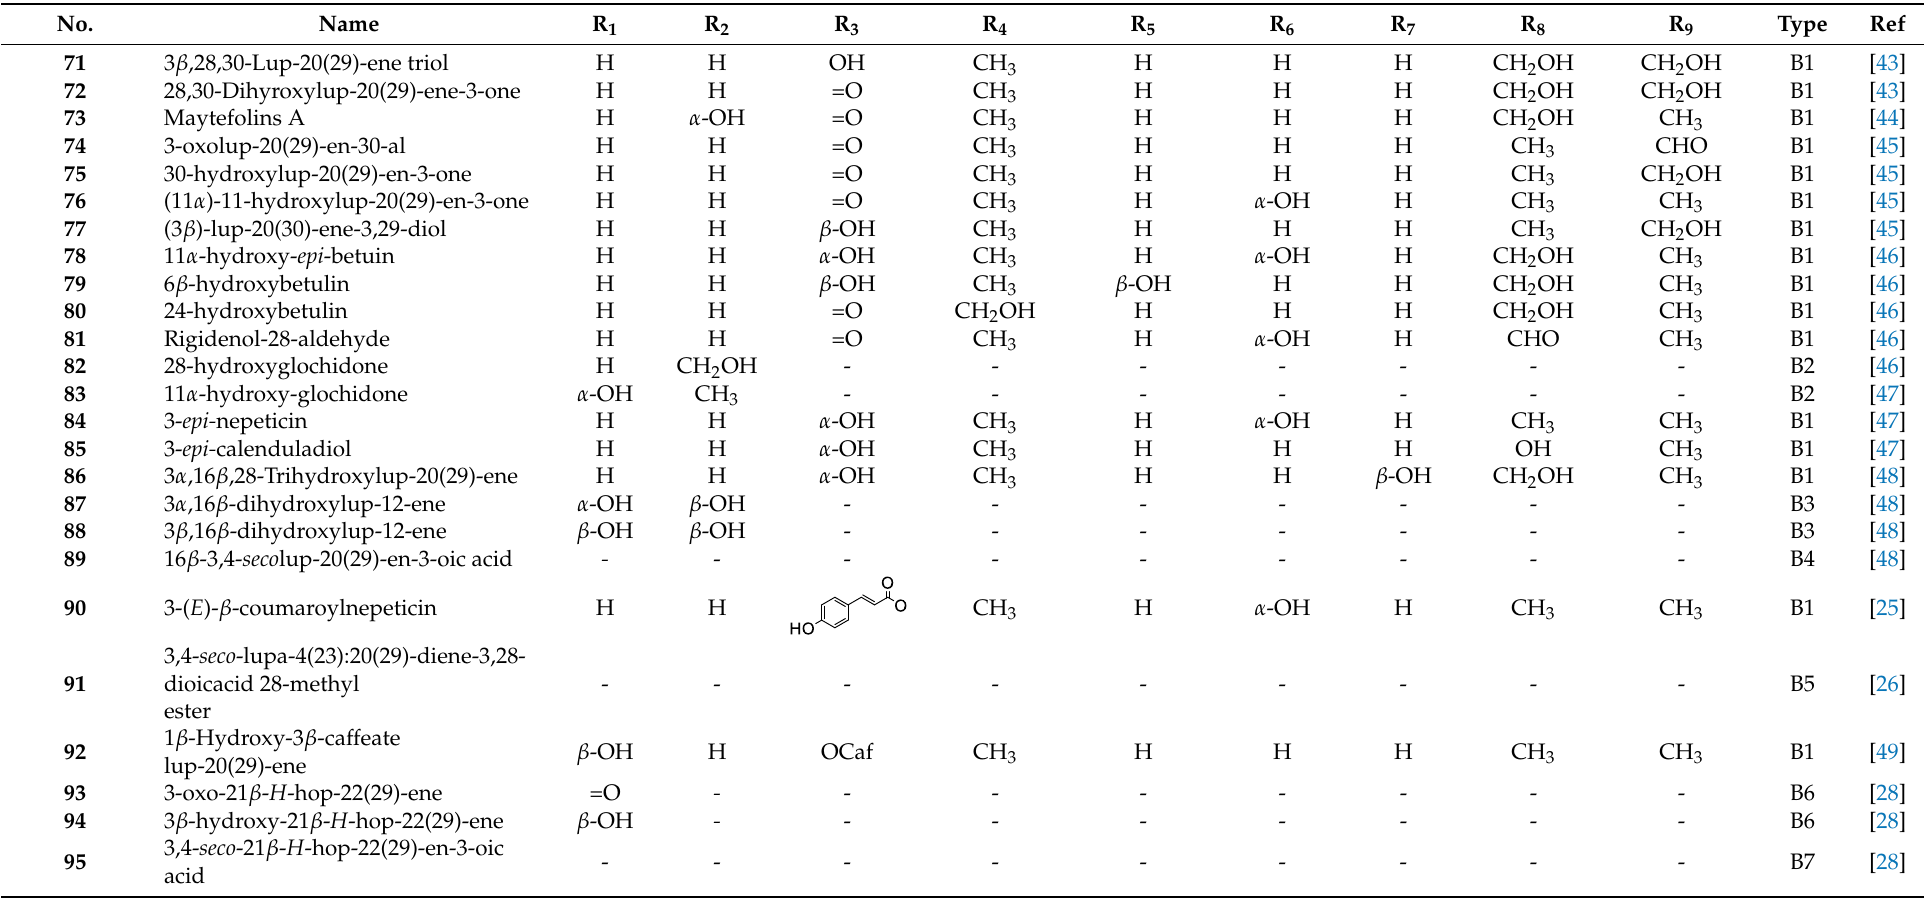
Table 2. The lupane triterpenes isolated from Maytenus .